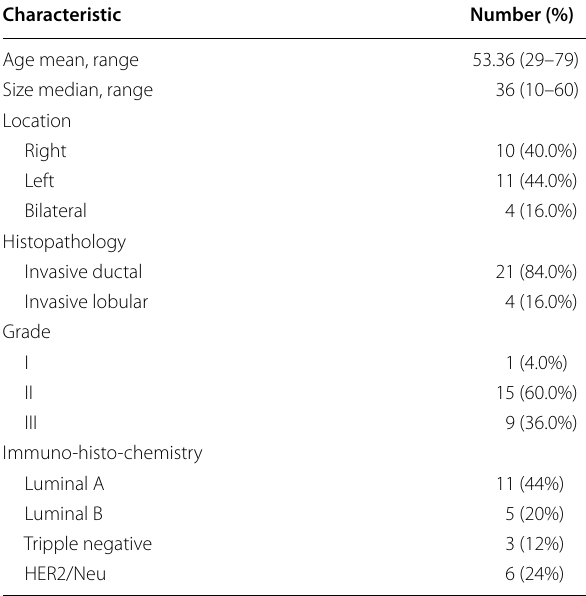
Table 1 Patient demographic Factors and tumor characteristics Characteristic